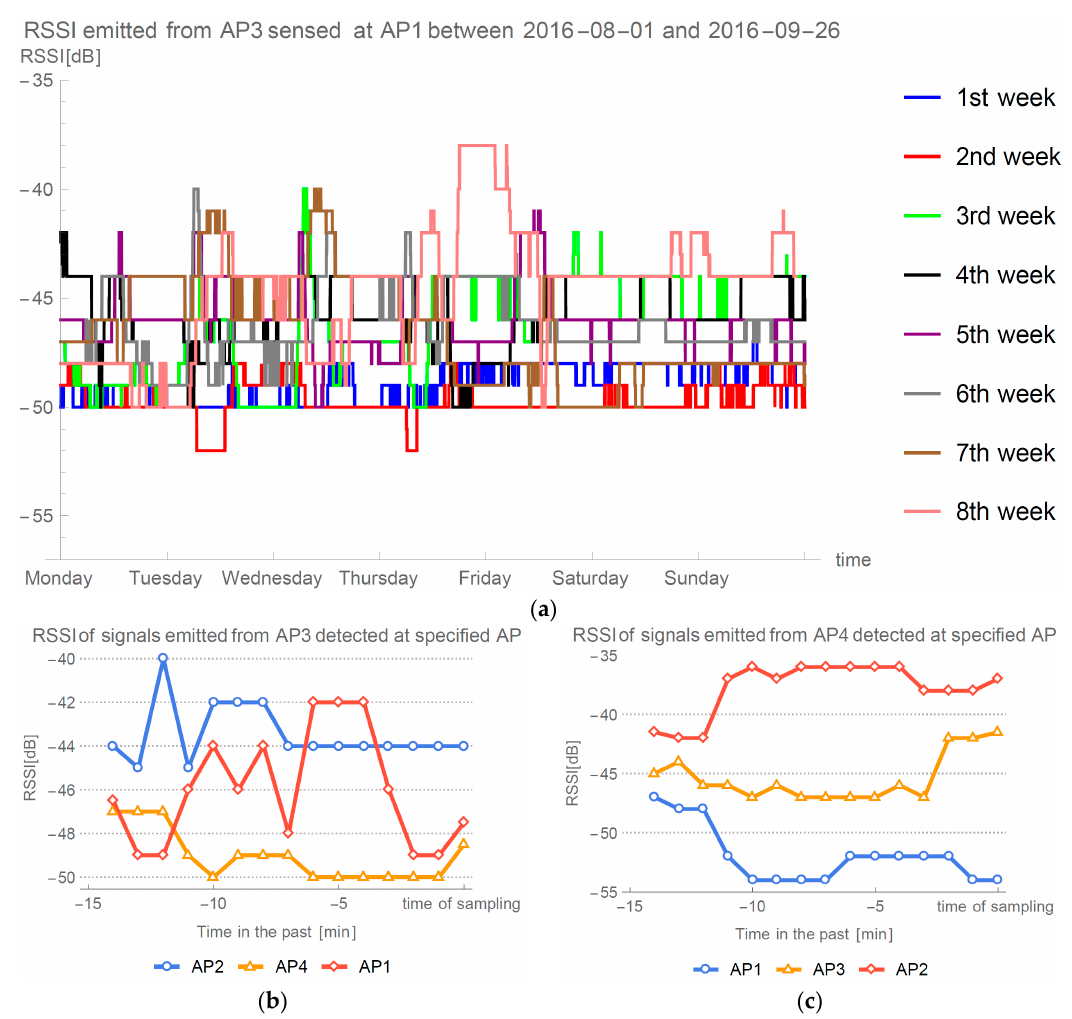
Figure 16. Analysis of unusual event on Thursday of the 8th week: ( a ) Analysis of RSSI from AP3 at AP1; ( b ) 15 min time frame of signals emitted from AP3 during unusual period; and ( c ) 15 min time frame of signals emitted from AP4 during unusual